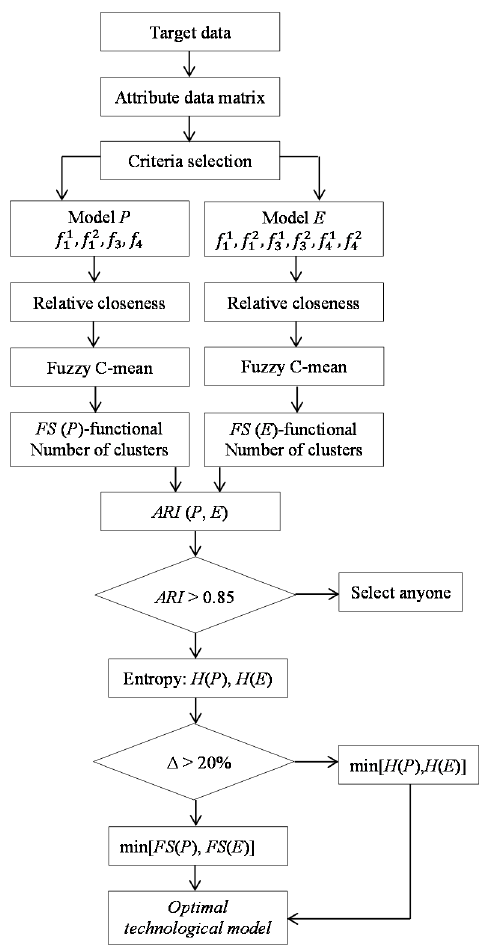
Figure 3. Model of the technological coal deposit.